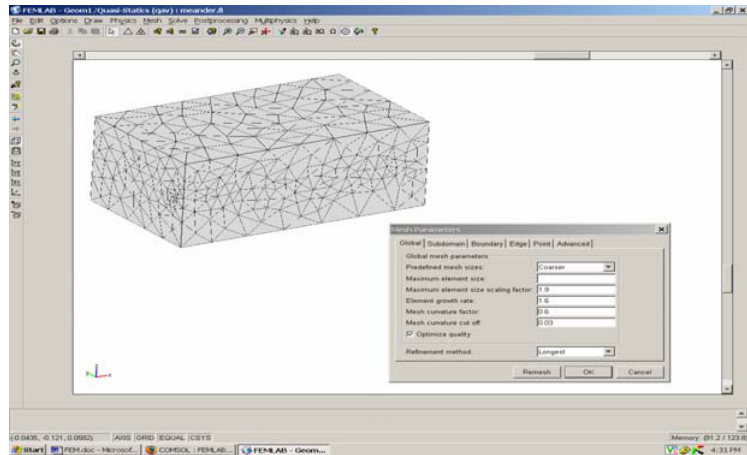
Figure 11. Model after finite element mesh generation.